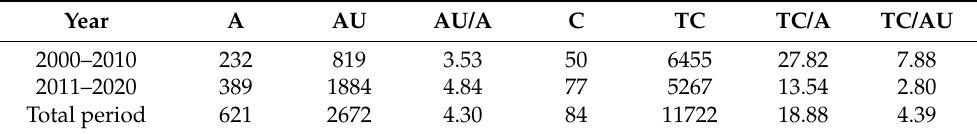
Table 1. Summary of